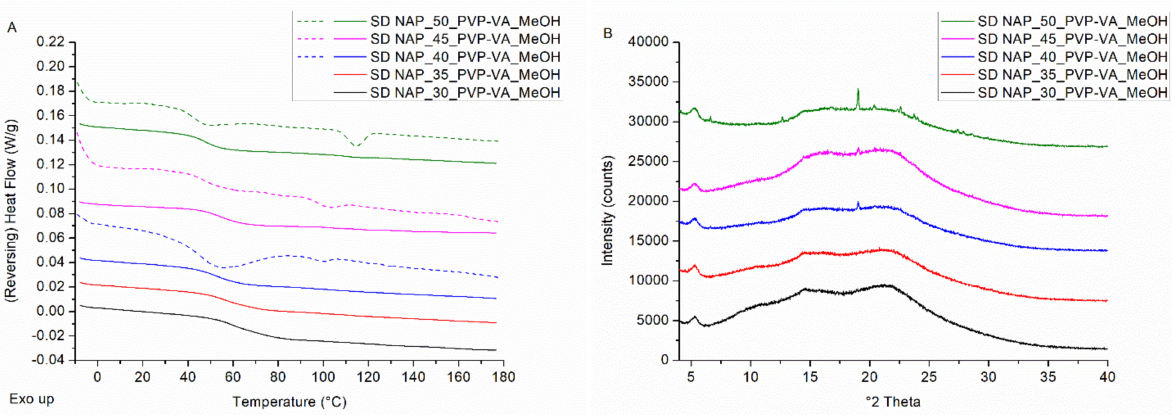
Figure 5. ( A ) mDSC thermograms of spray dried NAP–PVP-VA systems (SD), with drug loadings from 30% (black) to 50% (green) by intermediate steps of 5%. The THF (dashed) and RHF (solid) signals are shown as arbitrary units. ( B ) Corresponding XRPD diffractograms, where the intensities are also shown as arbitrary